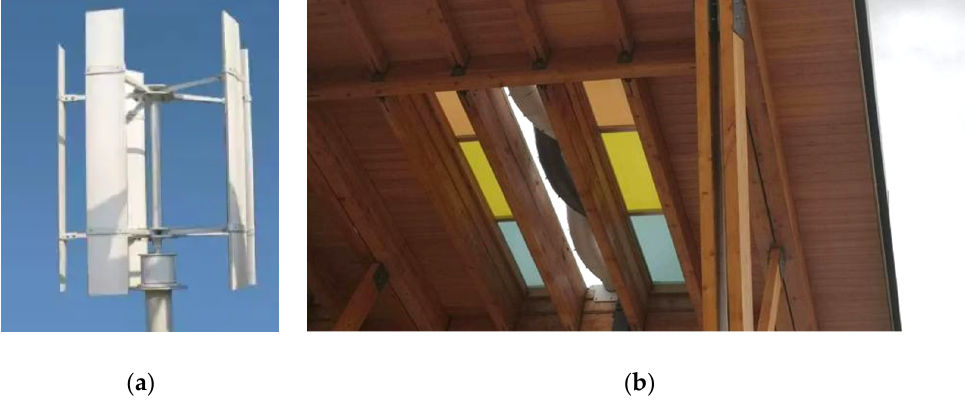
Figure 8. Turbine power generation equipment. ( a ) Solar Ark Vertical Axis Wind Turbine; ( b ) Tianjin U+ Wind Turbine.